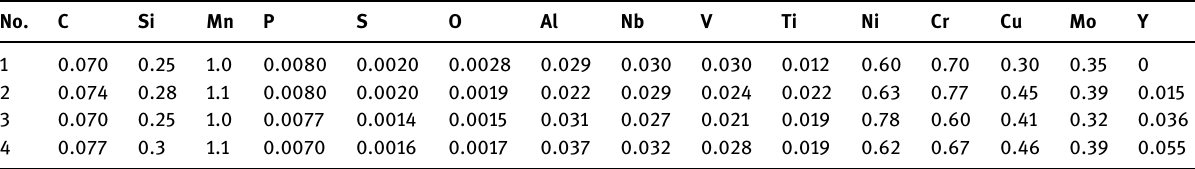
Table 1: Chemical compositions of test steels with and without addition of yttrium ( wt% )